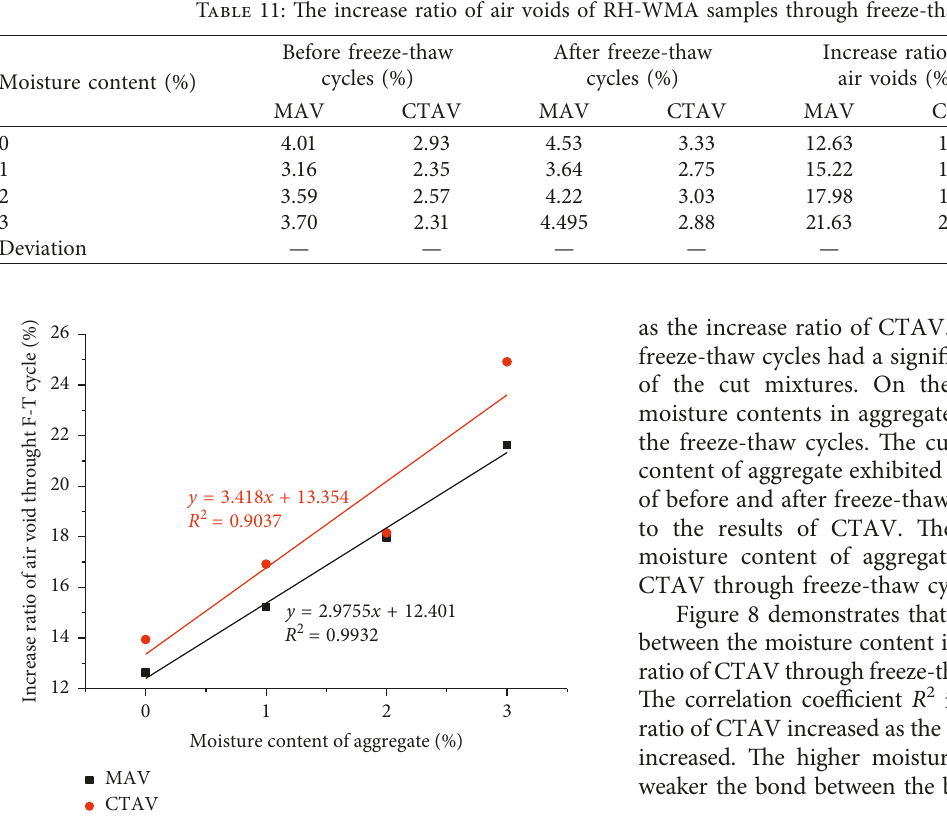
Figure 6: Moisture content in aggregates over increase ratio of air voids through freeze-thaw cycles.